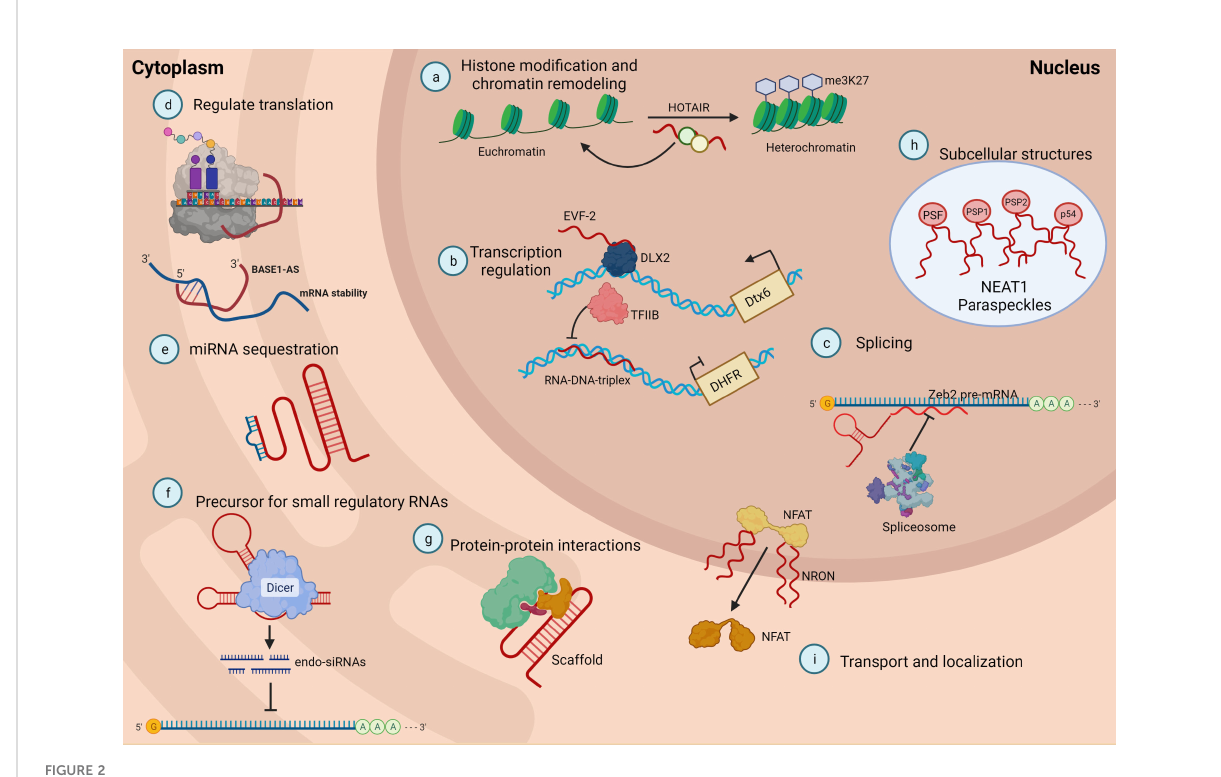
FIGURE 2 LncRNAs can be classi fi ed based on their functions. (A) lncRNA can guide chromatin complexes controlling between transcriptionally active euchromatin and silent heterochromatin; (B) the recruitment of polymerase II and transcription factors can be inhibited or facilitated by lncRNAs; (C) lncRNAs contribute to transcriptome complexity by regulating alternative splicing of pre-mRNAs; (D) lncRNAs affect the stability and translation of mRNA by base pairing with mRNA molecules; (E) they in fl uence in the expression of miRNAs by binding to them and preventing their function; (F) lncRNAs can act as siRNAs and target other RNAs, which subsequently could result in target degradation; (G) lncRNAs can join multiple protein factors as fl exible scaffolds to interact or cooperate on protein-protein interactions; (H), (I) the scaffold function is also important for protein activity and localization as well as subcellular structures. Adapted from Meng et al.